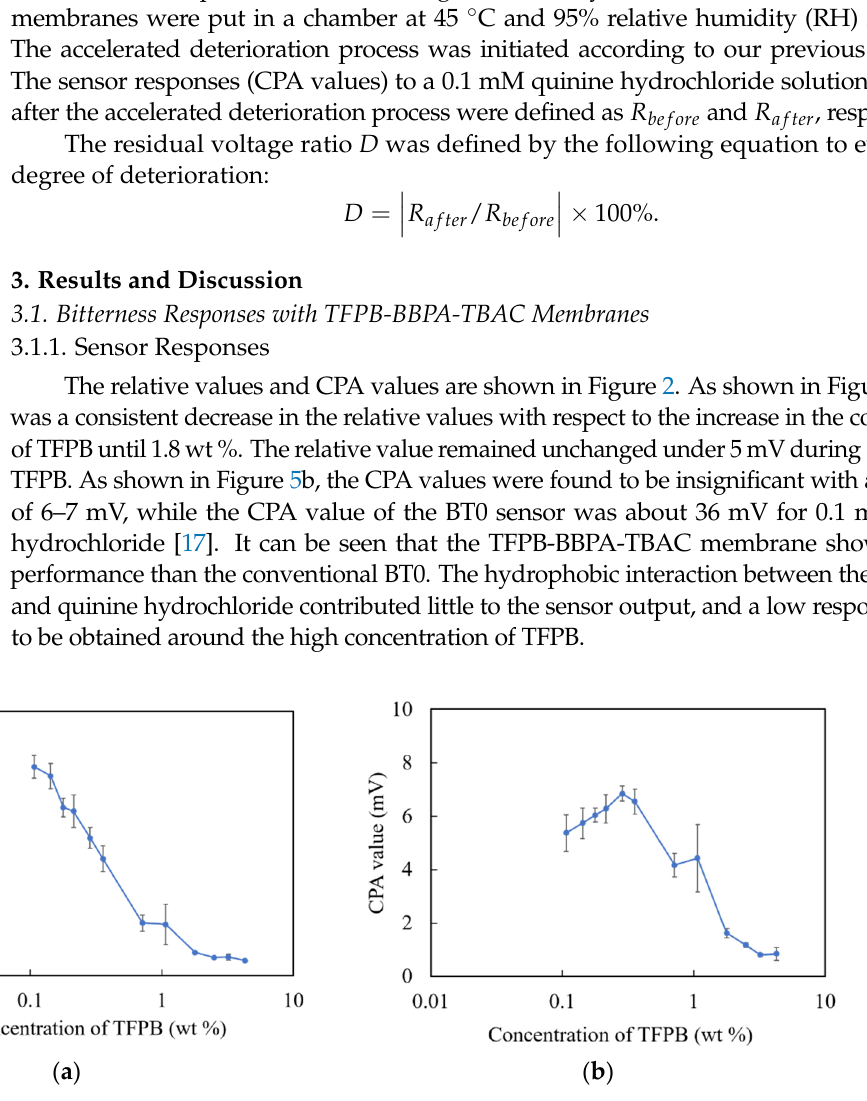
Figure 5. ResponsesofsensormembraneswithdifferentTFPBcontentsinTFPB-BBPA-TBACmembranestoquininehydrochloride (0.1 mM): ( a ) Relative values; ( b ) CPA values. The results are expressed as means ± SD ( n = 16, 4 membranes × 4